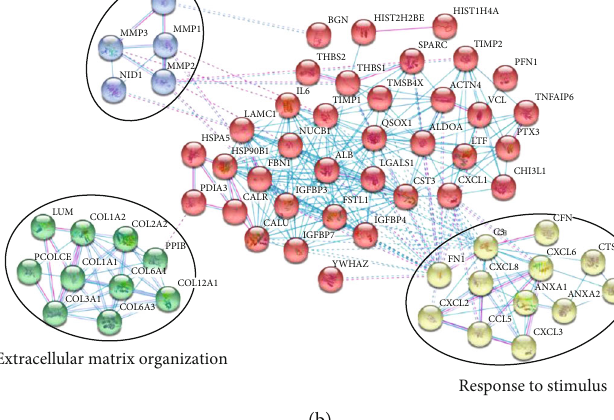
Figure 5: Protein-protein interaction (PPI) network analysis of commonly secreted proteins by all mesenchymal stem cells (MSCs) under normal (a) and in fl ammatory (b) conditions. The coloured lines represent the two types of evidence for active interaction sources. Light blue line, database evidence; purple line, experimental